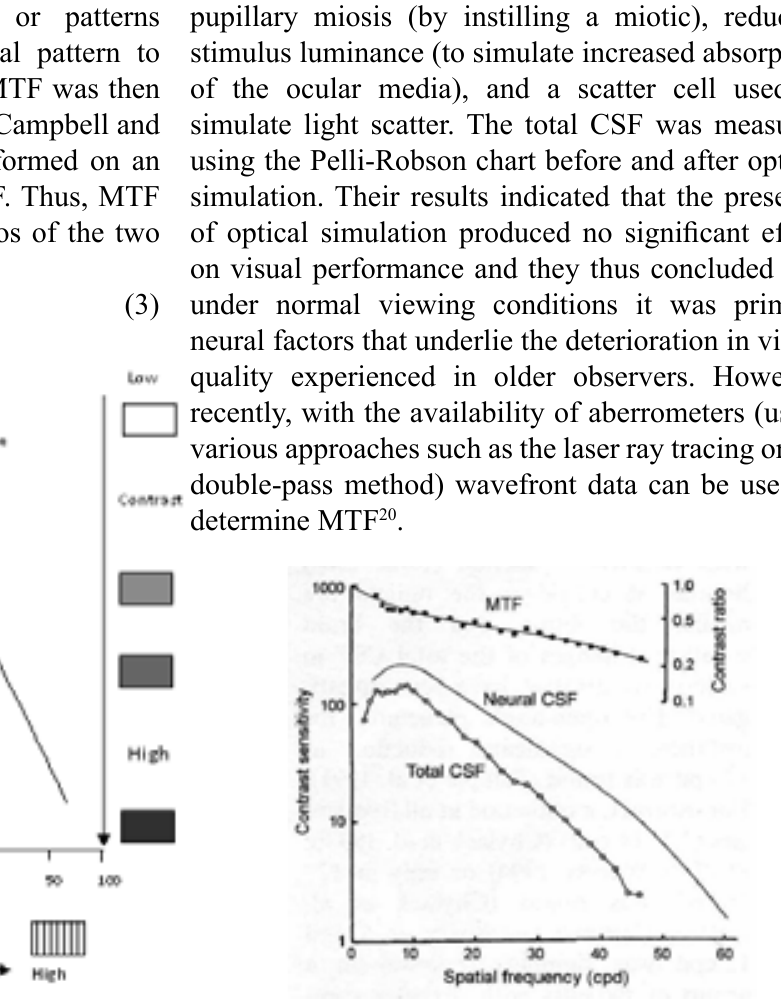
Figure 4. The contrast sensitivity function (CSF) is depicted by the inverted U-shaped curve; the boundary between seen and unseen gratings (or letters) is depicted by this curve. The figure has been adapted from Norton, Corliss, and Bailey 1 .